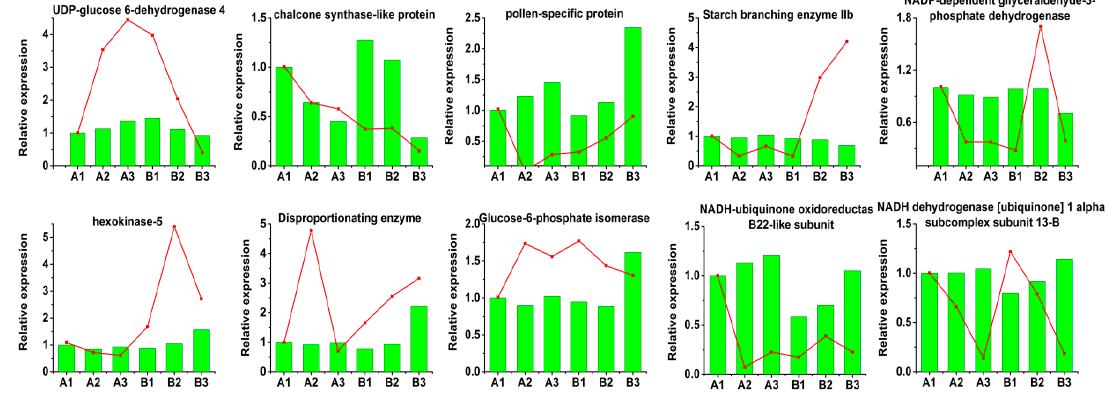
Figure 10. Relative expression levels of some differentially expressed proteins. The red line shows the qRT-PCR results and the histogram represent the proteomics data. The data obtained by qRT-PCR are the means based on three